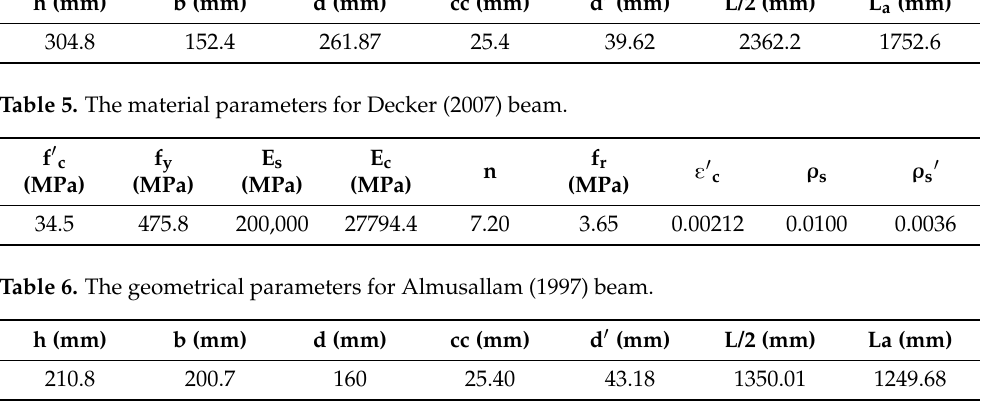
Figure 17. Ahmad and Batts (1991) [17] moment vs. maximum compressive strain analytical graphs.